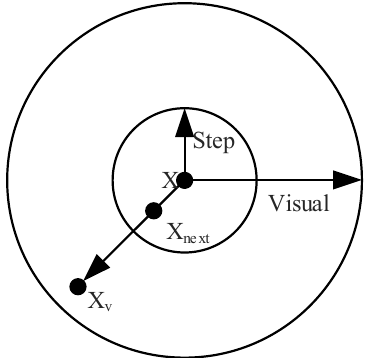
Figure 17. Sketch of visual and step of the artificial fish.